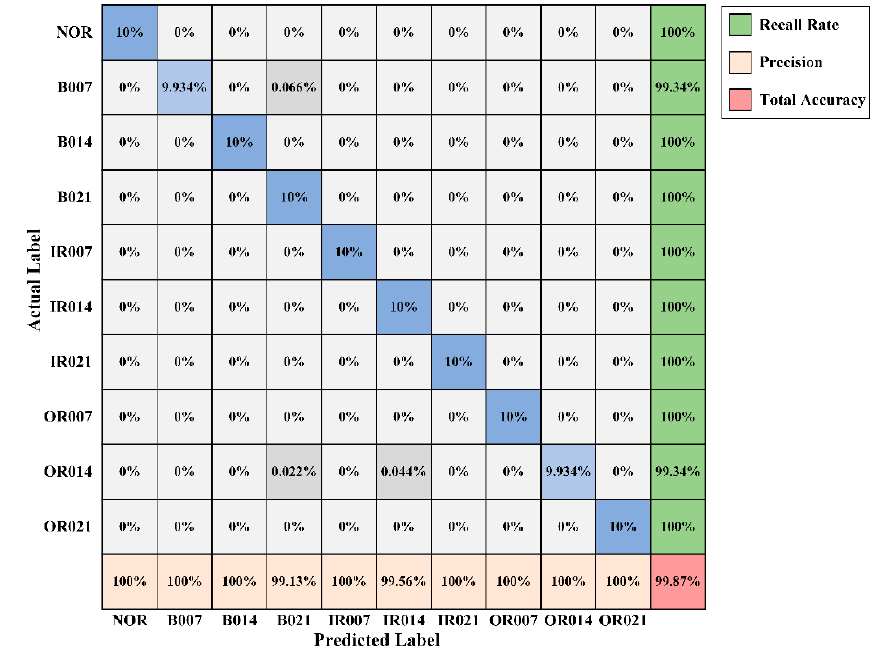
Figure 9. Confusion matrix of the best trial of WPT-CNN in Case One.